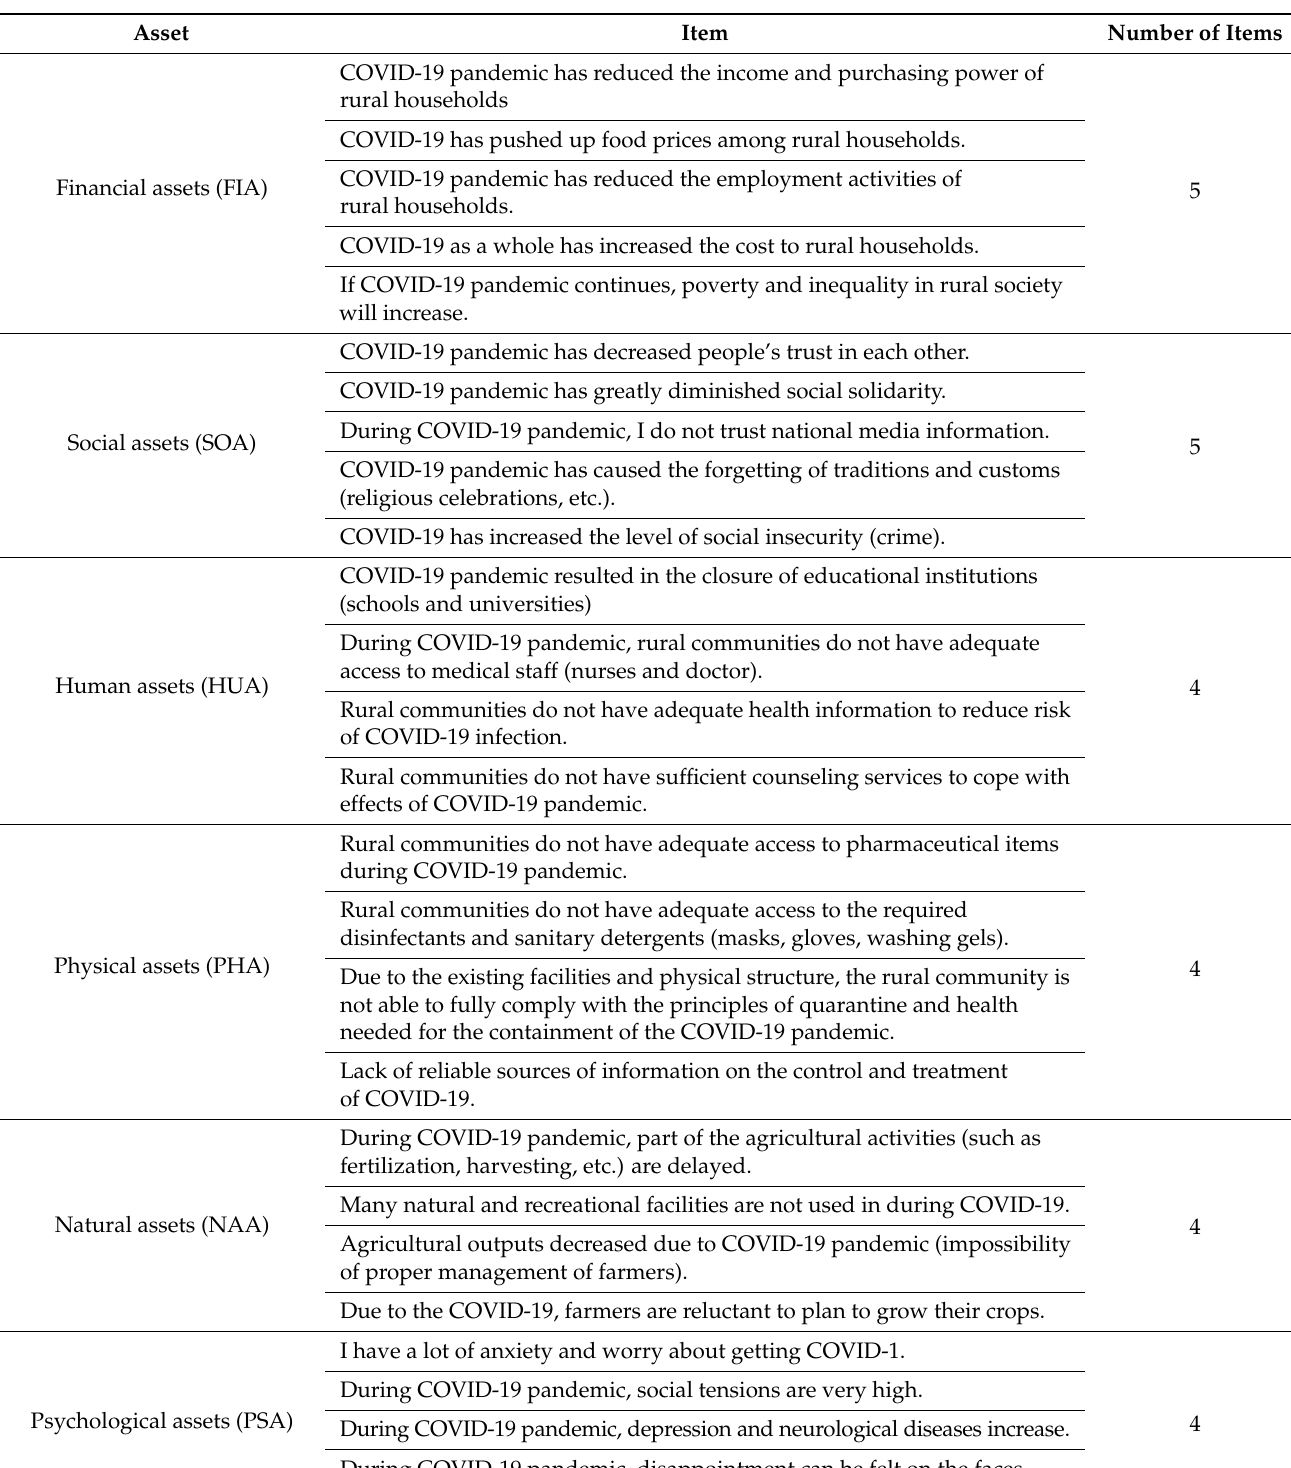
Table 2. Livelihood assets assessment